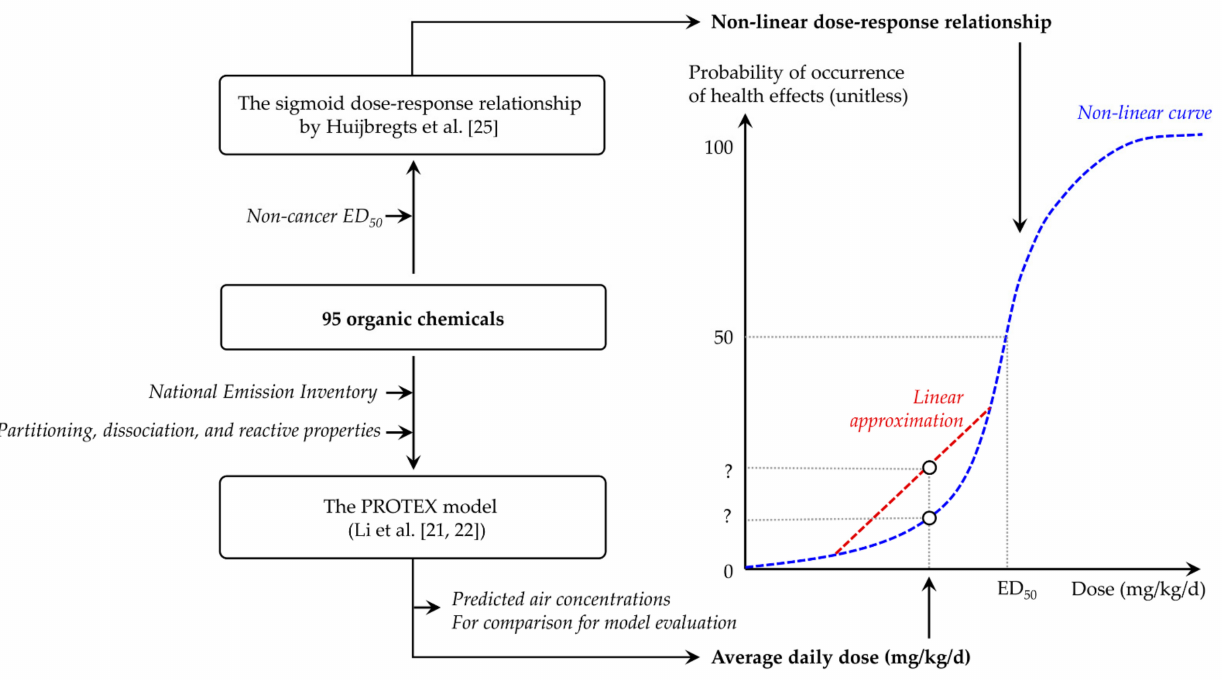
Figure 1. Schematic overview of the modeling approach in this